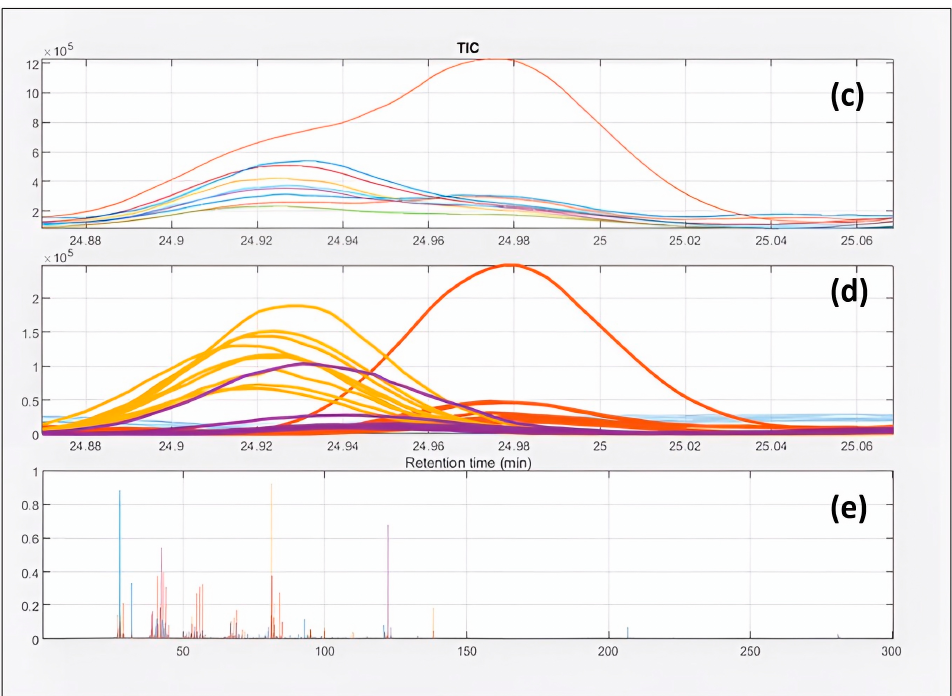
Figure 2. The number of components (y-axis) chosen is depicted by a red circle ( a ). The value of the x-axis indicates the Fit% of the model. The greyscale ( b ) gives immediate information on the number of peaks described by te model. Thanks to the user-friendly GUI, it is possible to look simultaneously at: Total Ion Current (TIC ( c )), the components resolved by PARAFAC2 ( d ), and the mass spectra of each component ( e ). Table 1. Identified headspace volatile compounds in the bread samples with their retention time and match